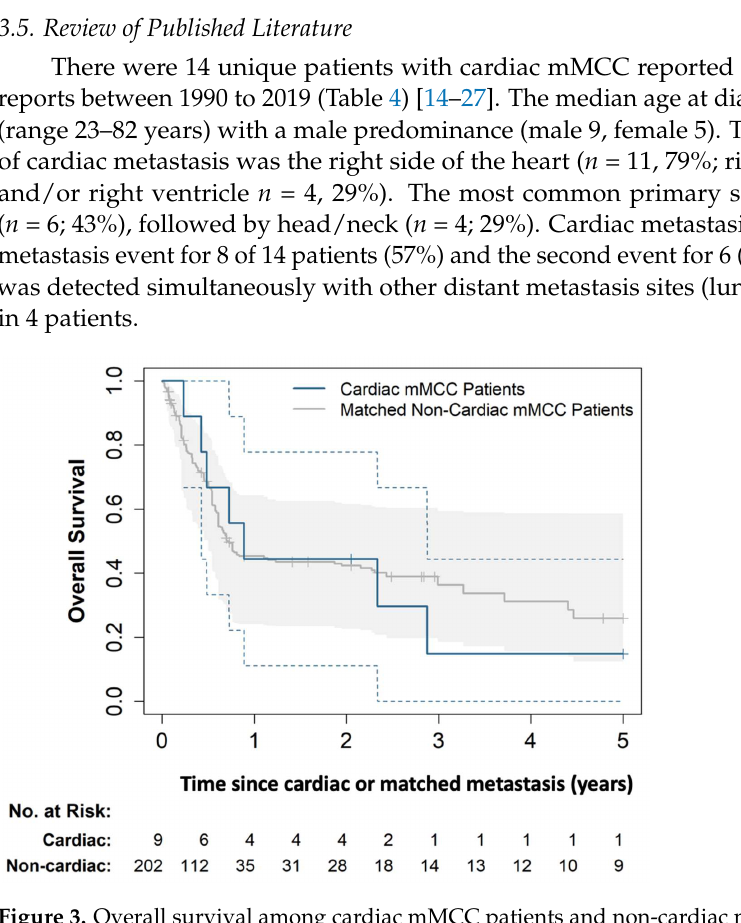
Figure 3. Overall survival among cardiac mMCC patients and non-cardiac mMCC patients matched by number of prior metastases. Overall survival (OS) of the cardiac mMCC patients (blue line) and matched non-cardiac mMCC patients (gray line). The OS time was calculated starting from the date of cardiac mMCC diagnosis for the cardiac mMCC patients and starting from the date of the matching non-cardiac mMCC diagnosis for the non-cardiac mMCC patients. The matching non-cardiac mMCC diagnosis was the one with the same number of prior metastatic episodes as the matched cardiac mMCC patient at the time of the cardiac mMCC diagnosis (see the supplemental materials for more detail on the matching). The 95% confidence intervals for the two survival curves are shown using the blue dashed lines and solid gray region, respectively. The tick marks on each curve indicate censoring times. The two curves were not statistically significantly different ( p = 0.96 by the stratified log-rank test).